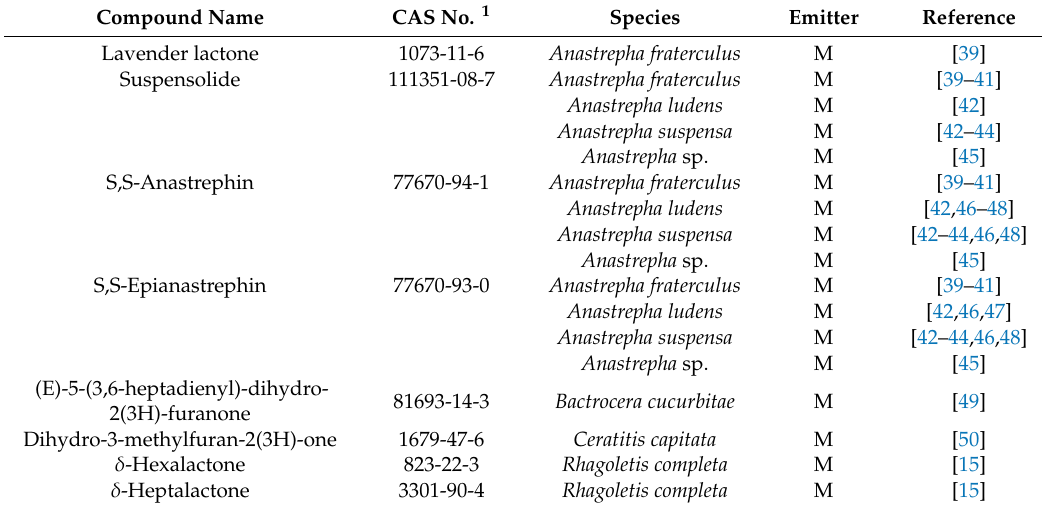
Table 2. Lactones produced by Tephritidae